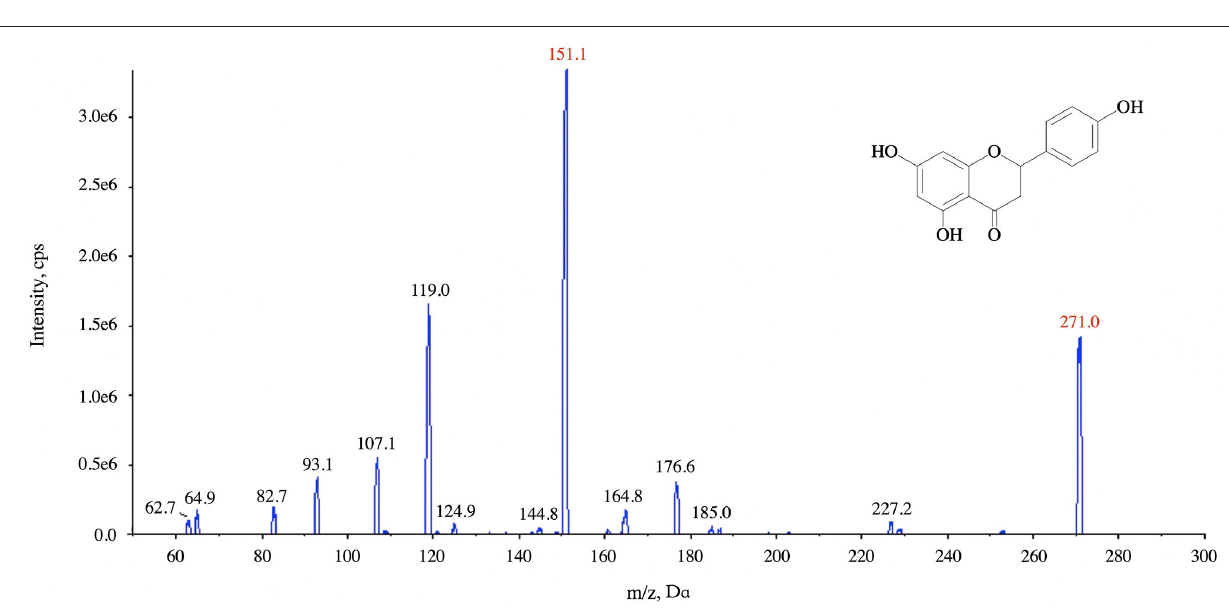
FIGURE 3 | Tandem mass spectra of ion at m/z 151.1 and m/z 119.0 with the collision energy at − 26 and − 35eV,